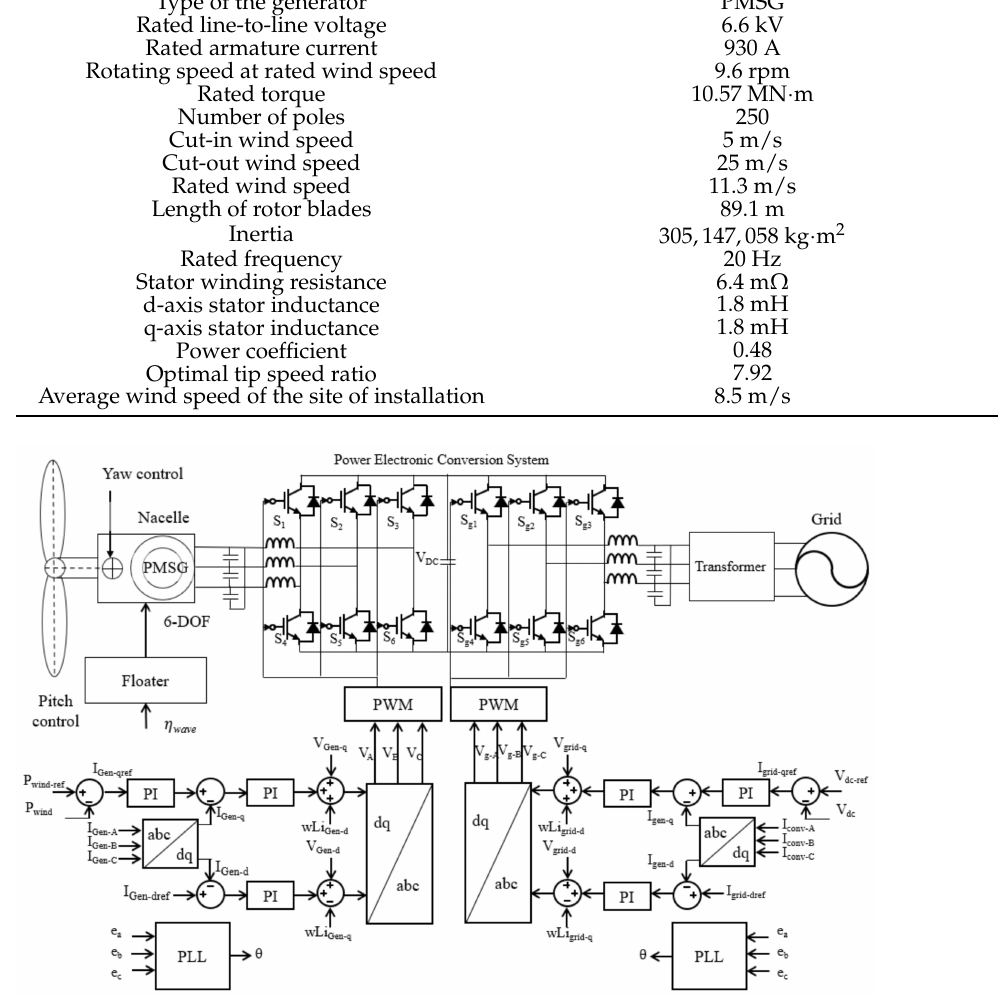
Figure 1. Configuration of the modeled 10 MW